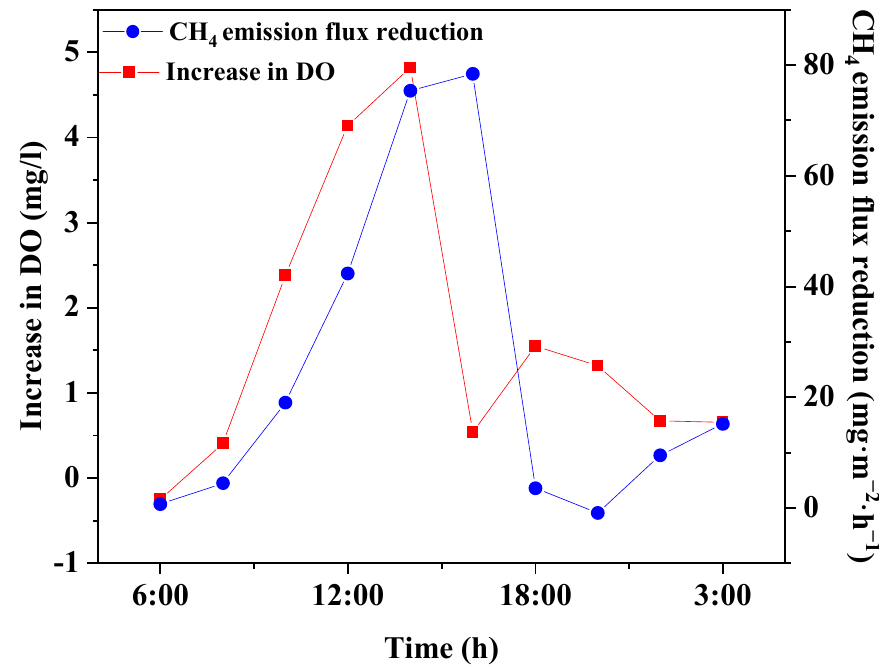
Figure 9. Relationship between the DO increment and CH 4 emission flux reduction .